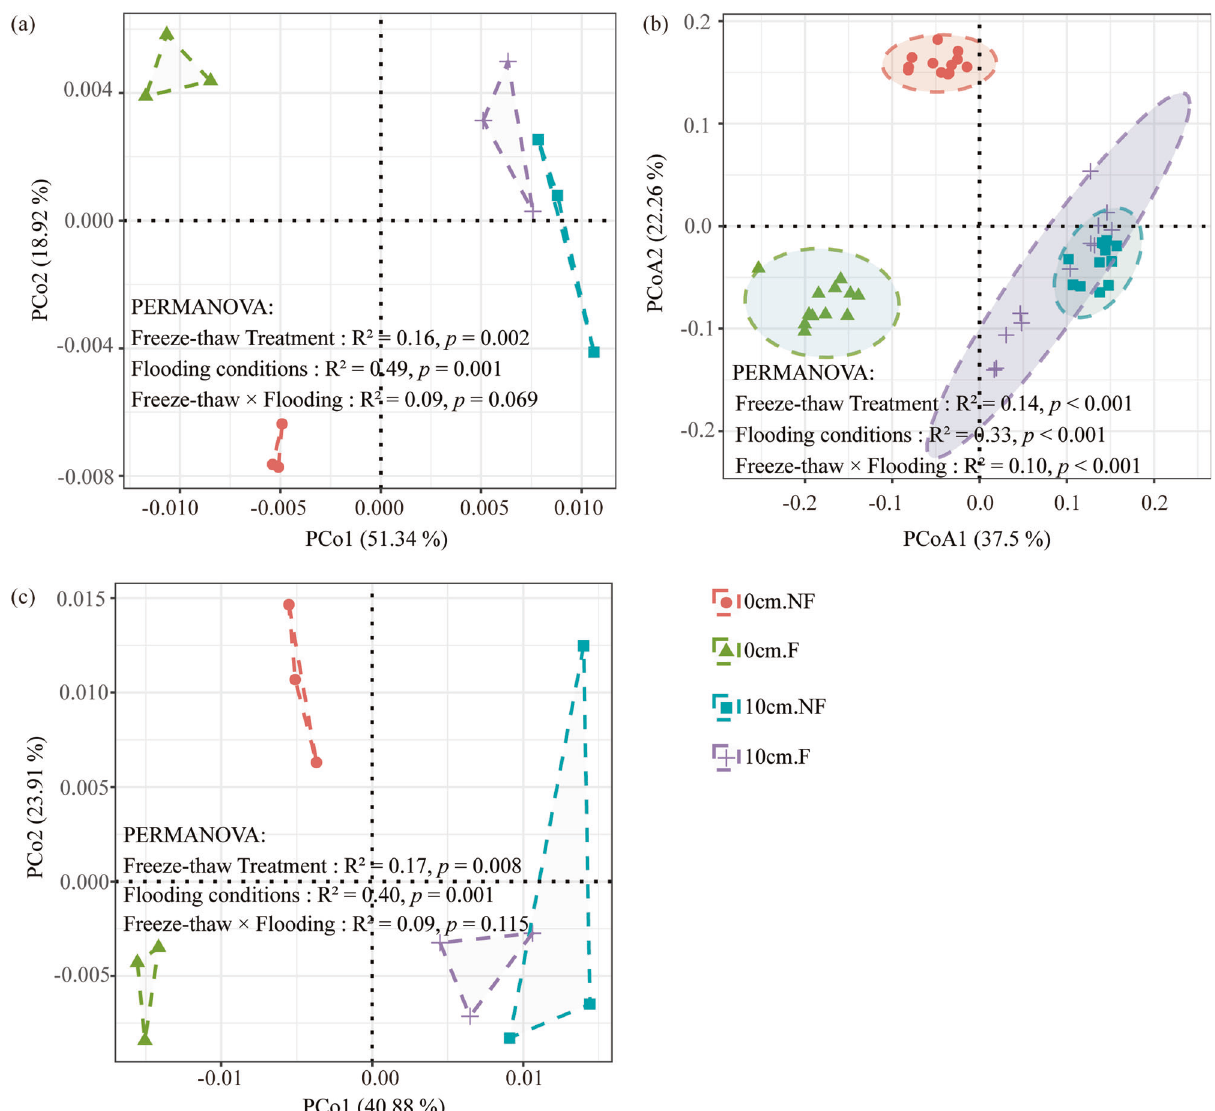
Fig. 2 Responses of beta diversity of microbial community and functions to the carry-over effects of freeze-thaw under fl ooding conditions. a PCoA results of N-cycling functional genes; b PCoA results of microbial community composition based on OTU, shadings represent 95% con fi dence ellipses for groups; c PCoA results of denitri fi cation functional genes; 0 cm. F: non- fl ooding × freeze-thaw; 0 cm. NF: non- fl ooding × control; 10 cm. F: fl ooding × freeze- thaw; 10 cm. NF: fl ooding ×